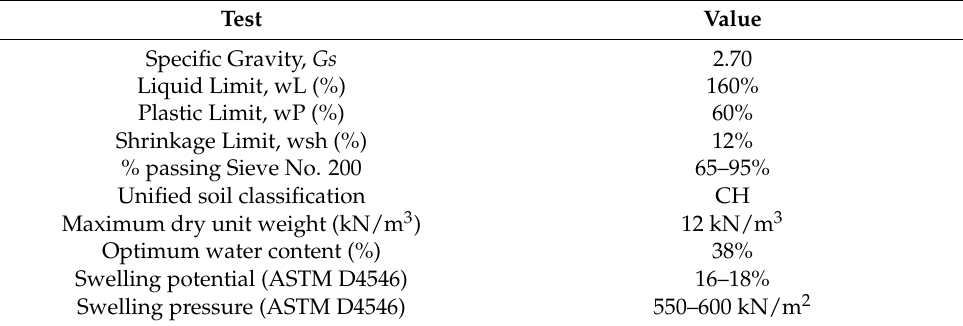
Table 1. Soil Characterization for Al-Qatif Soil.